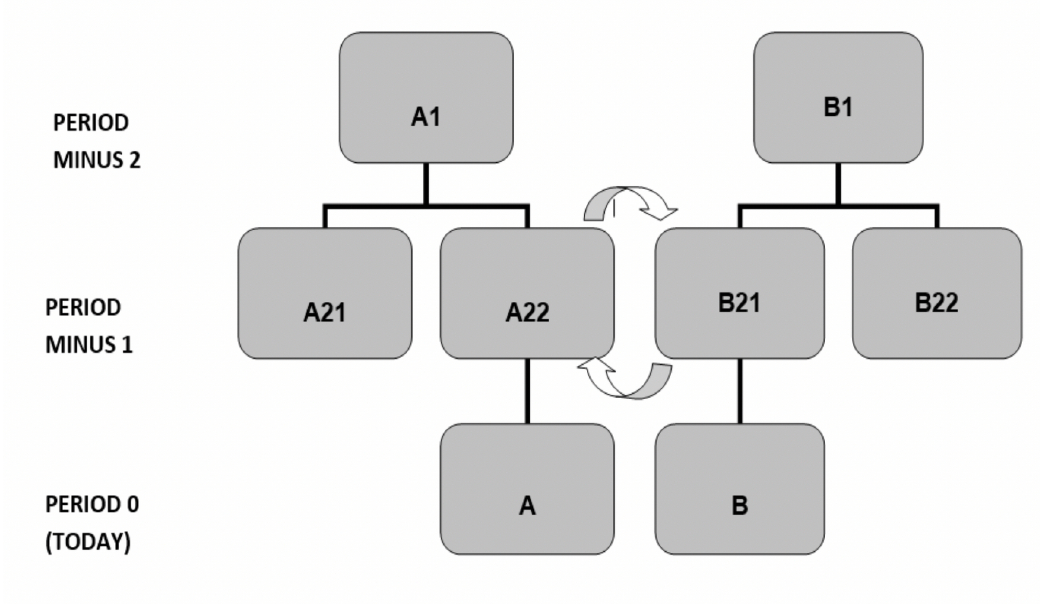
Figure 3. Co-Evolutionary